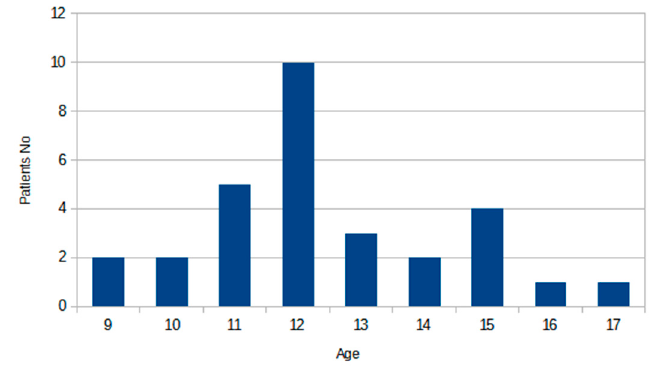
Figure 1. Distribution of the age of the patient within the dataset.